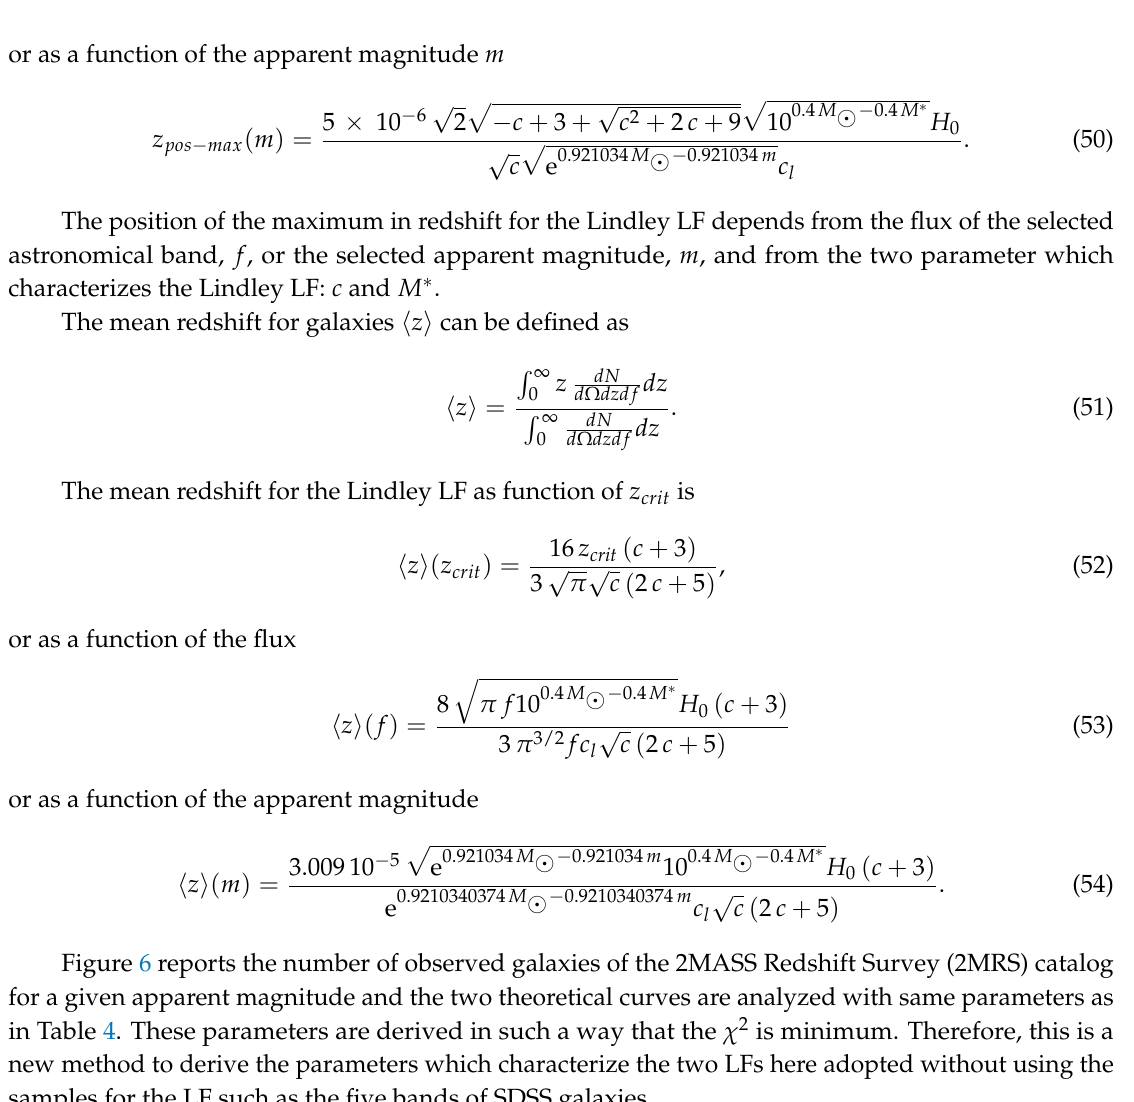
of the two LFs applied to K S band (2MASS Kron magnitudes) red